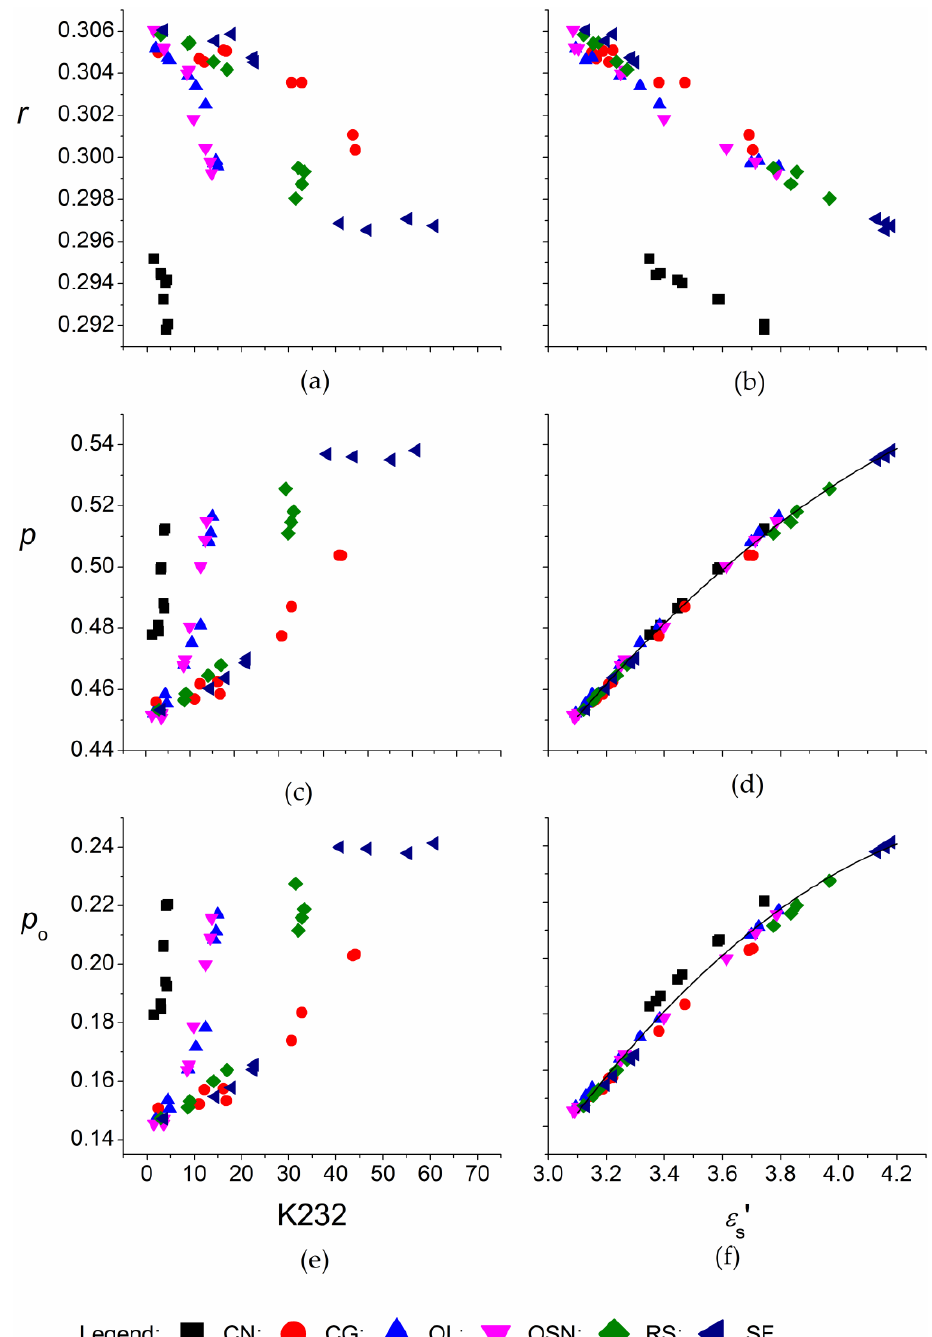
Figure 4. Dependence of the specific refraction, r ( a , b ), specific polarization, p ( c , d ), and specific orientation polarization, p o ( e , f ) on the sum of the specific absorption coefficient K232 ( a , c , e ) and the dielectric constant, ε s ( b , d , f ) for the edible oils thermally treated at 180 °C. CN, coconut oil; CG, corn-germ oil; OL, olive oil; RS, rapeseed oil; SF, sunflower oil; and OSF, high oleic acid sunflower.